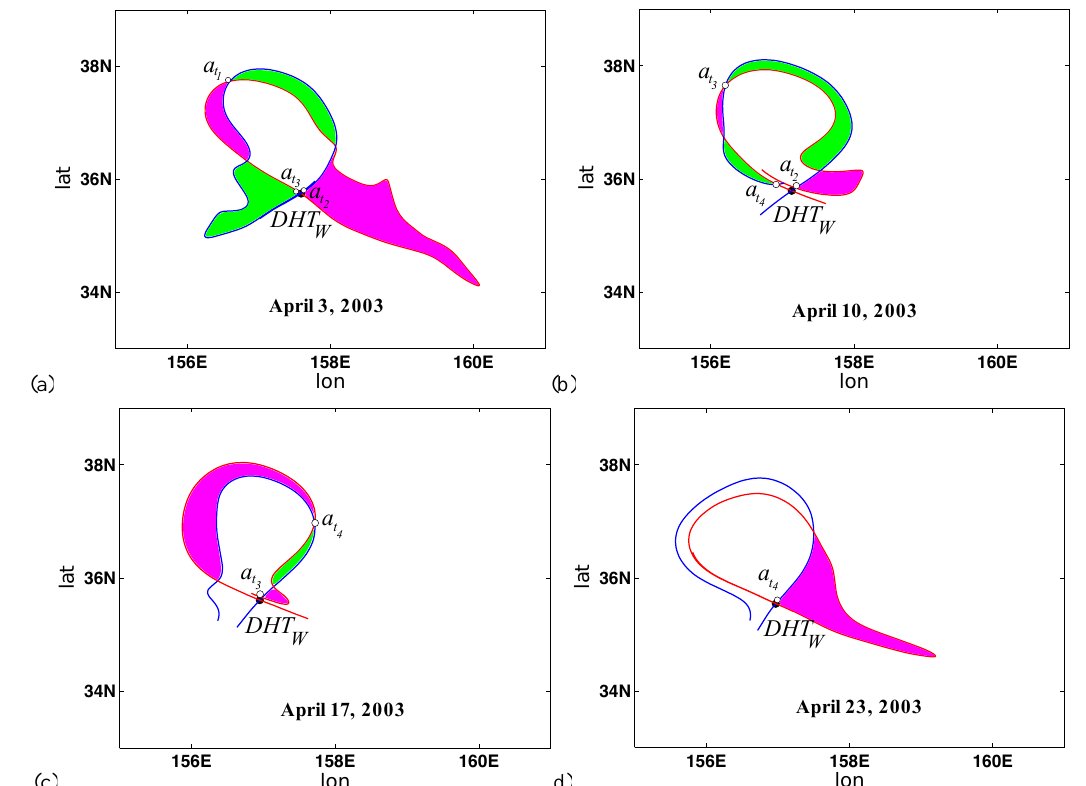
Fig. 20. Sequence of lobes mixing waters from inside the eddy to outside and viceversa in selected days of year 2003. (a) 3 April; (b) 10 April; (c) 17 April ; (d) 23 April.